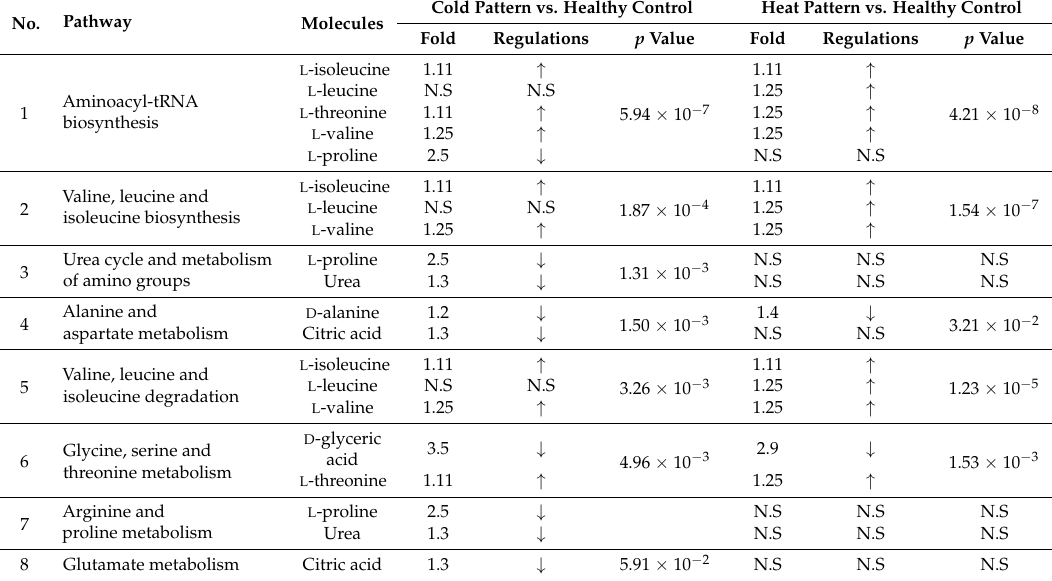
Table 1. Comparison of cold pattern vs. healthy control and heat pattern vs. healthy control in amino acids metabolism ( ↑ , upregulation, ↓ , downregulation, N.S, no significance). Cold Pattern vs. Healthy Control Heat Pattern vs. Healthy Control No. Pathway Molecules